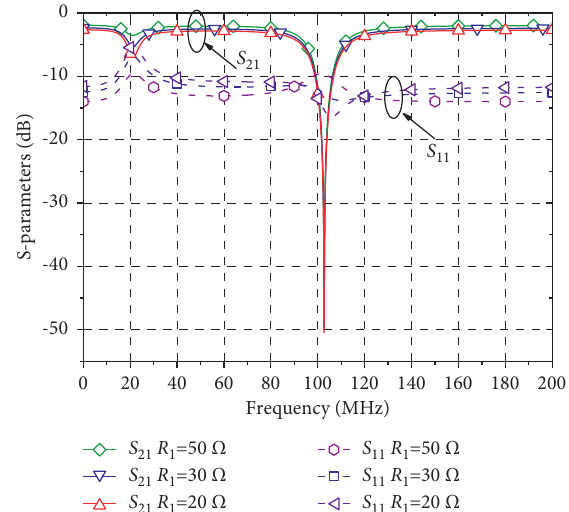
Figure 13: S parameters of the band-stop filter with band-pass negative delay at different R